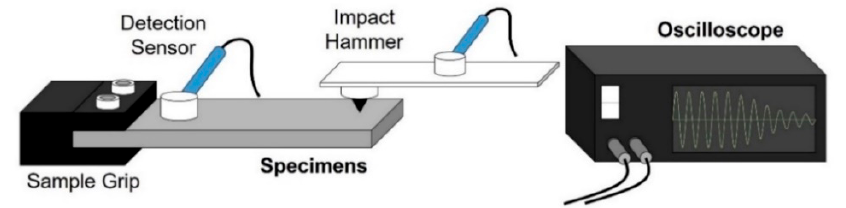
Figure 2. Schematic illustration of equipment for the observation of damping capacity.